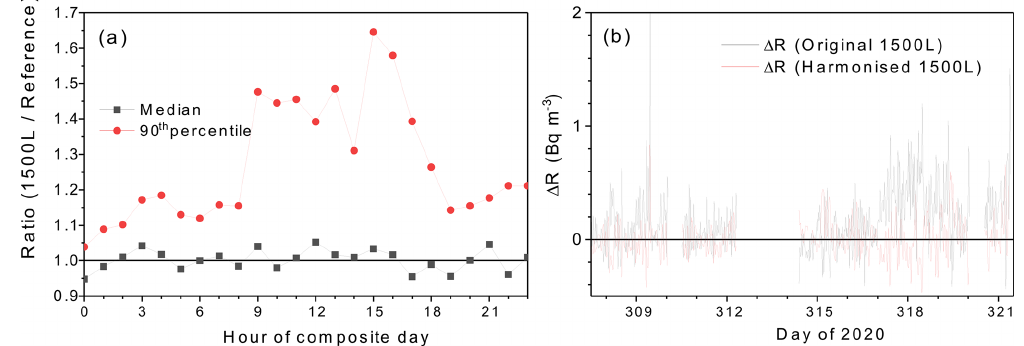
Figure 17. (a) Median and 90th percentile values of the LGHS to reference monitor ratio over a composite diurnal cycle formed from the whole 2-week measurement period, and (b) corrected and uncorrected concentration differences between the